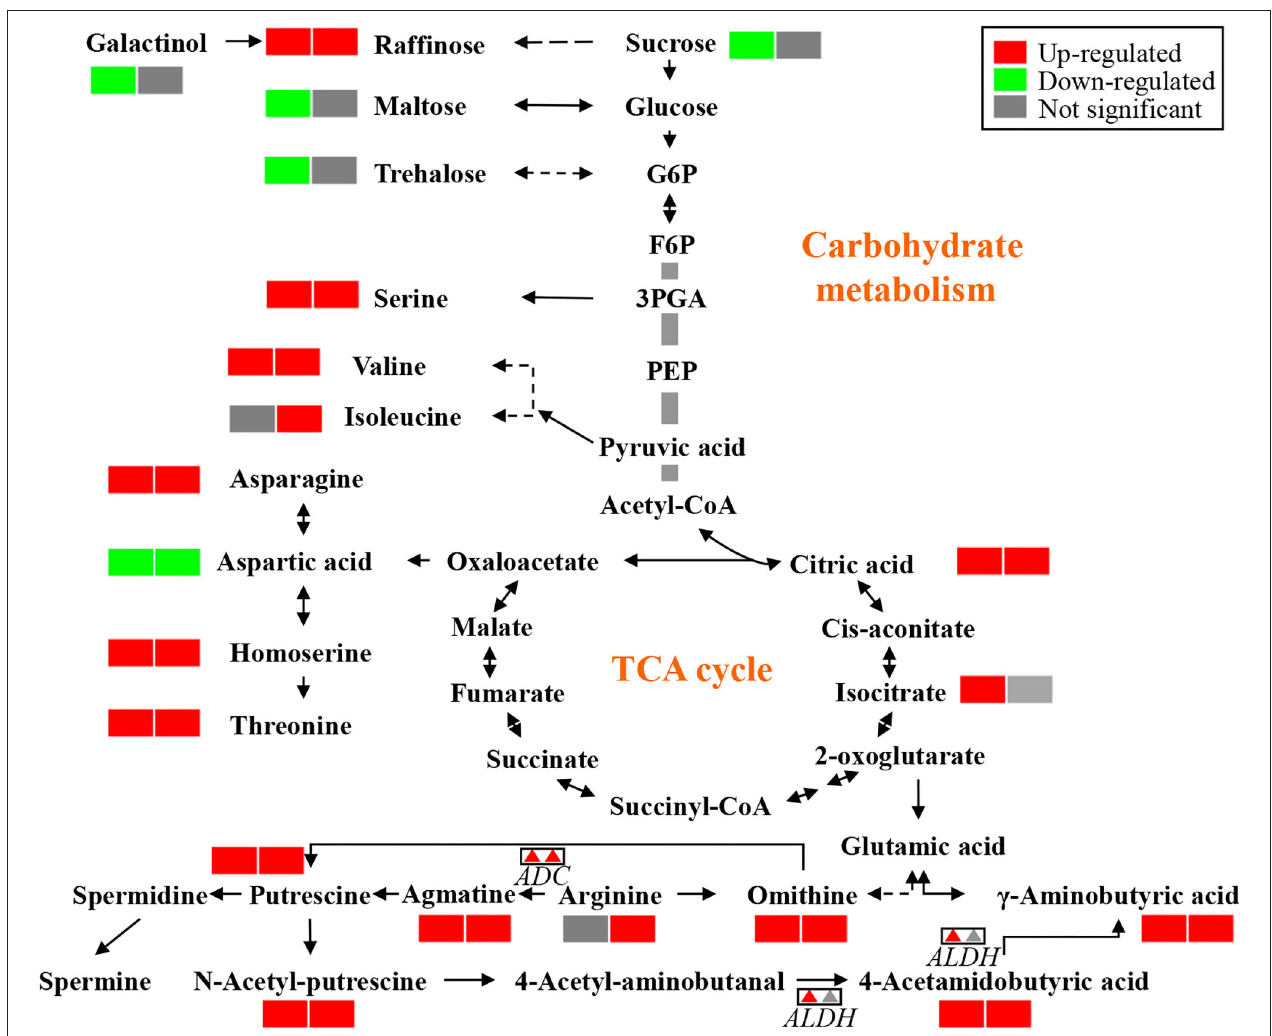
FIGURE 5 | The metabolites that varied significantly in DH605 and Z58 after exposure to K + deficiency. The first and second box of each metabolite indicates the varied metabolites of DH605 and Z58 after exposure to K + deficiency, respectively. The first and second triangle of each gene indicates the varied genes of DH605 and Z58 after exposure to K + deficiency,